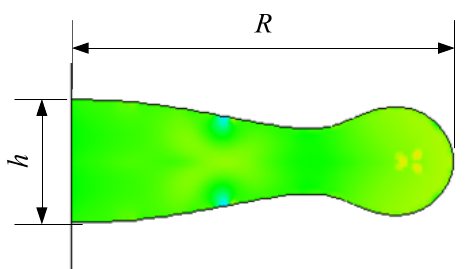
Figure 13. Schematic of fluid radial